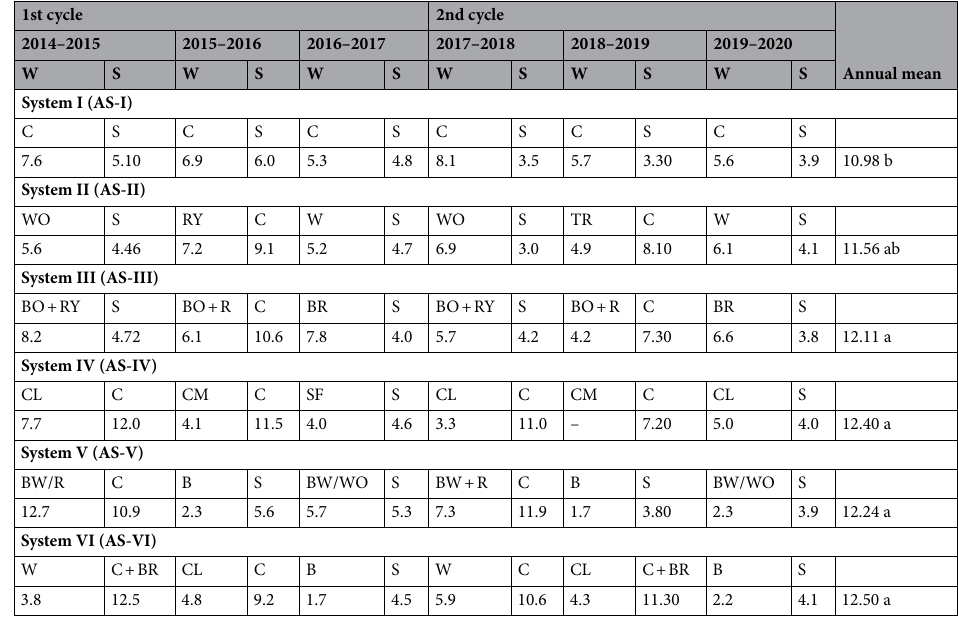
Table 3. Dry matter (Mg ha −1 ) of the grain production systems for the 2014–2015 to 2019–2020 crop years in Londrina, state of Paraná, Brazil. W winter, S summer, WO white oat, BO black oat, BR brachiaria, CL canola, CM crambe, RY rye, SF safflower, B bean, C corn, R forage radish, S soybean, W wheat, BW buckwheat,